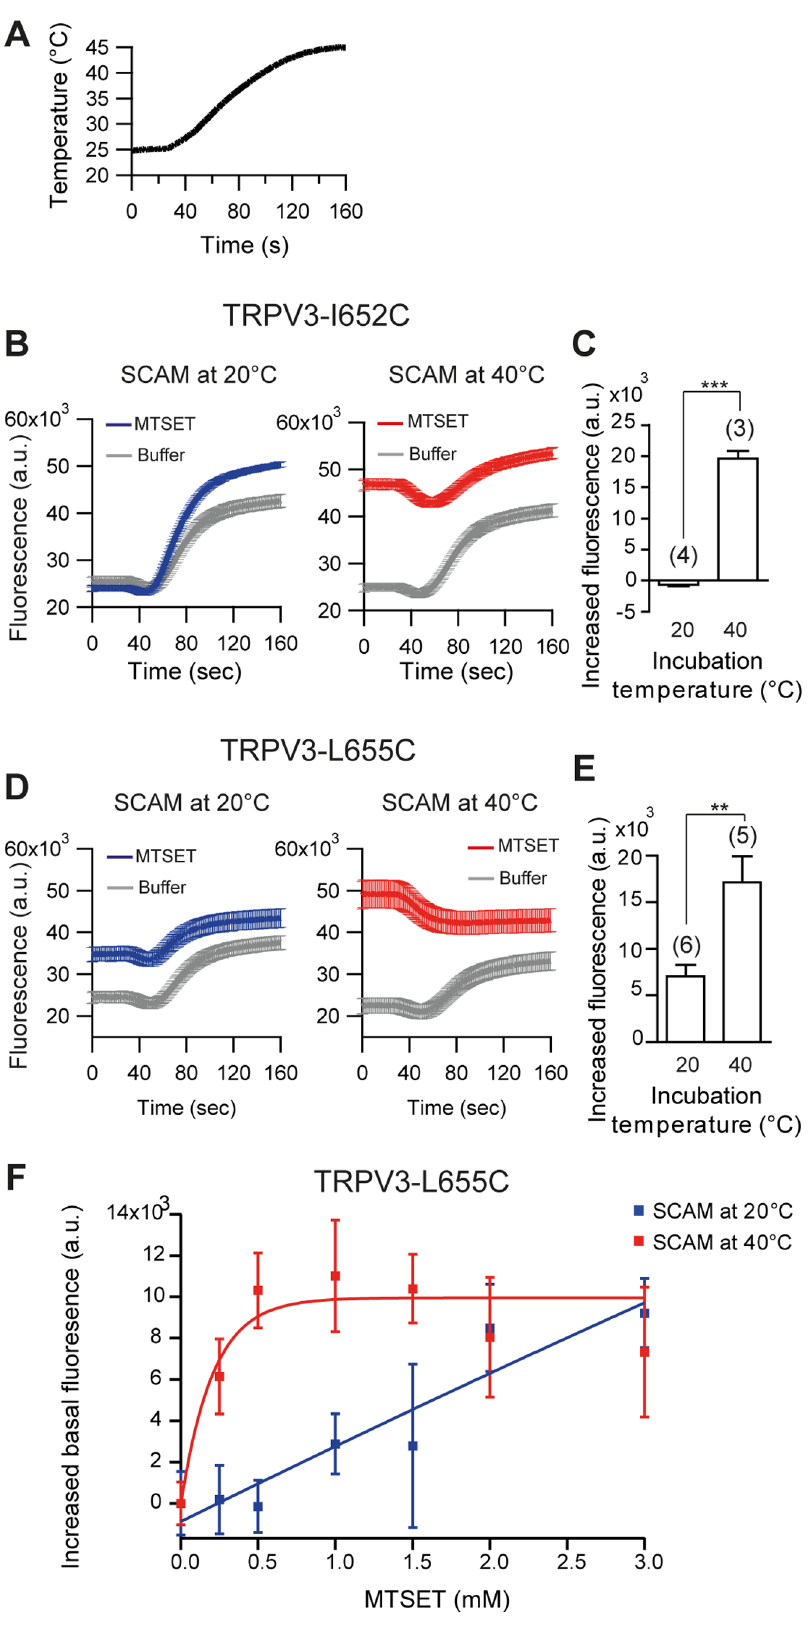
Figure 3. Temperature-dependent labeling in TRPV3. (A) Temperature as a function of time during FLIPR temperature-activation assay. (B) Representative examples of fluorescence responses upon temperature stimulation of TRPV3 I652C. n . 8 wells. Error bars are mean 6 2x s.e. (C)